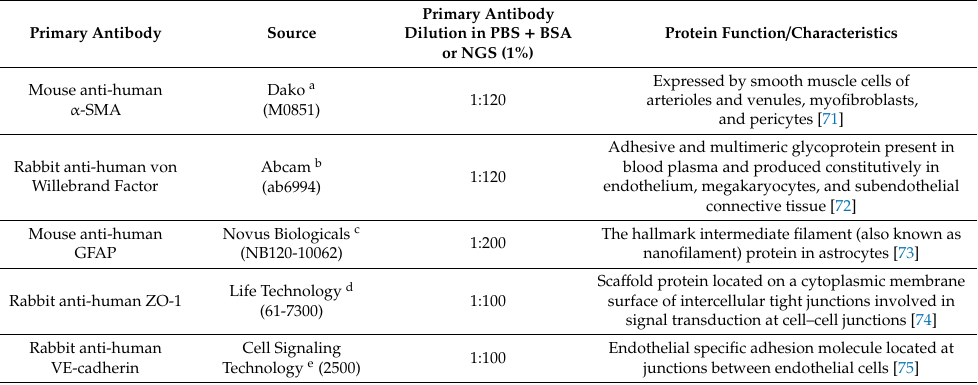
Table 1. Details of primary antibodies used for fluorescence